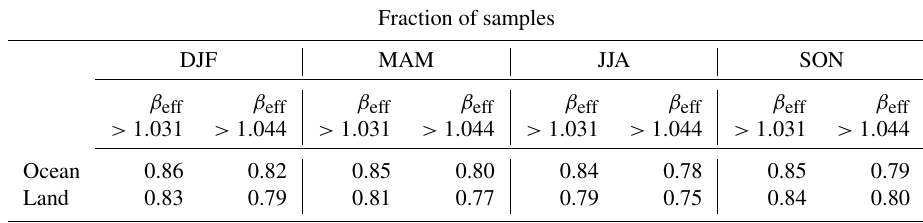
Table 2. Fraction of samples with IIR β eff larger than the N/ IWC and D e sensitivity limit, per season in 2013, over ocean and over land. Fraction of